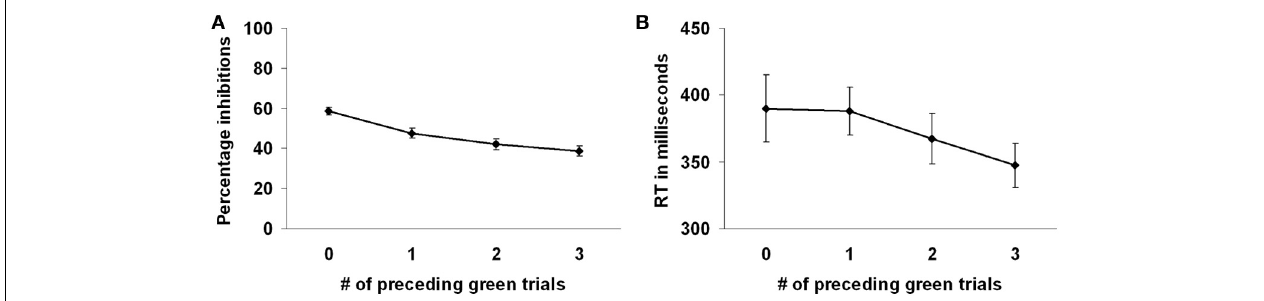
FIGURE 2 | Preceding context effects in the marble task. (A) Participants inhibited more frequently with less preceding green trials. (B) Reaction times on the white marble trials were faster with more preceding green trials.